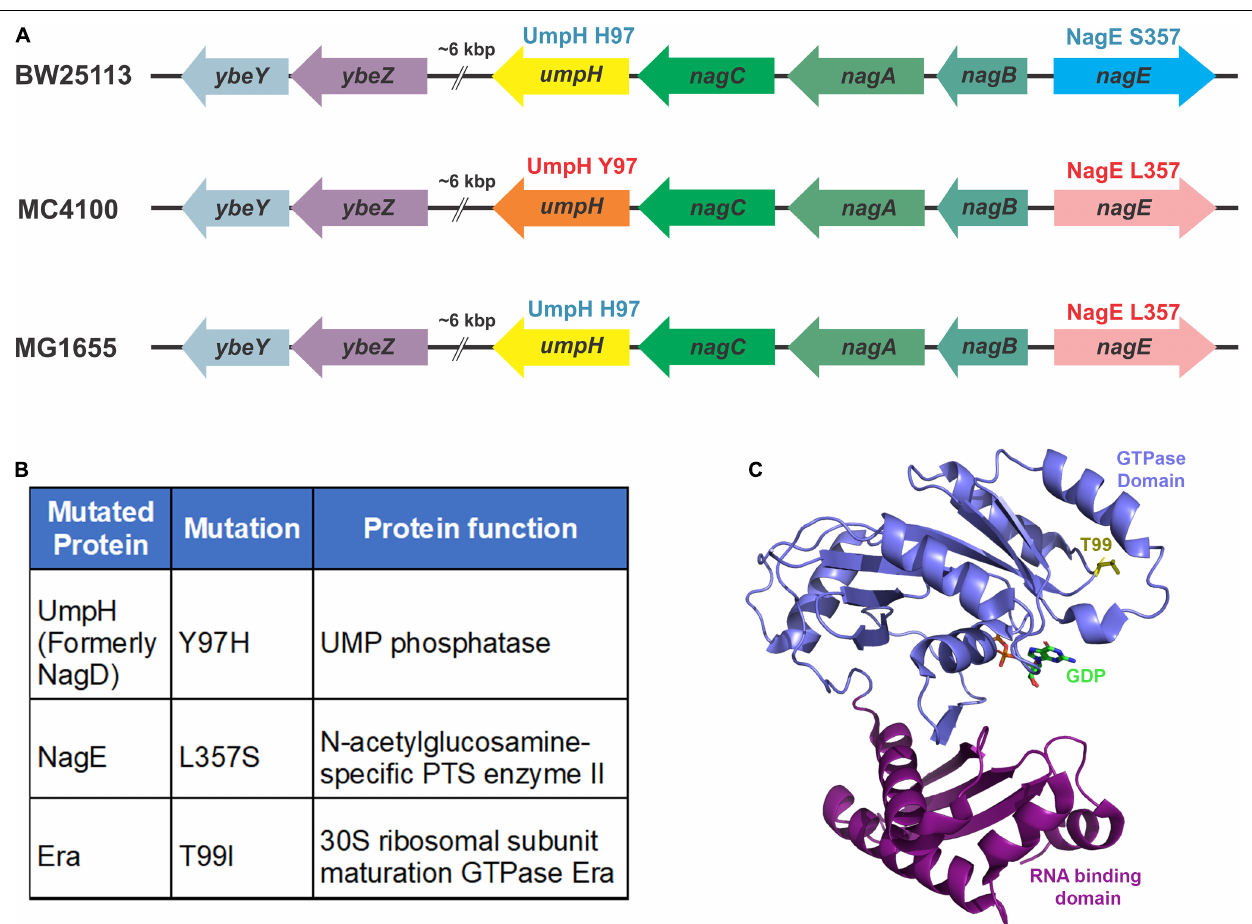
(cid:49) ybeY(sup1) strain. Compared to the era( + )